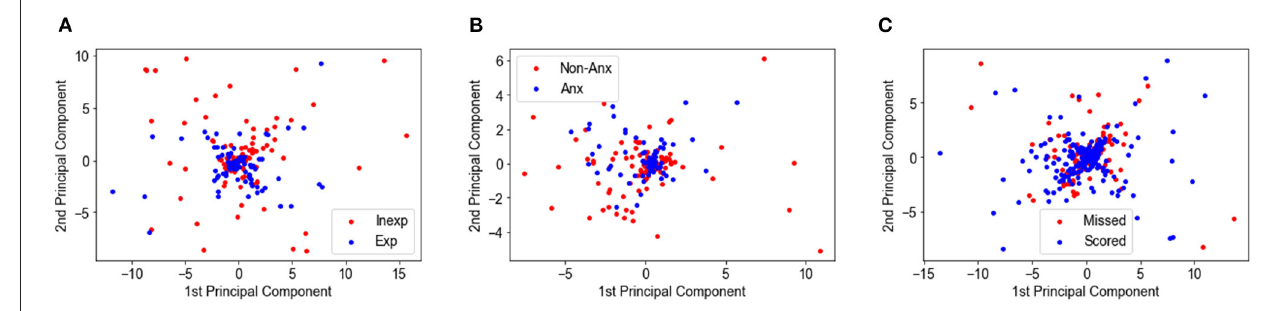
FIGURE 6 | Data distribution projected to first and second principal components for classifying: (A) experienced vs. inexperienced players using motor cortex data; (B) anxious vs. non-anxious players using averaged PFC data; (C) scored vs. missed penalties using the PFC asymmetry